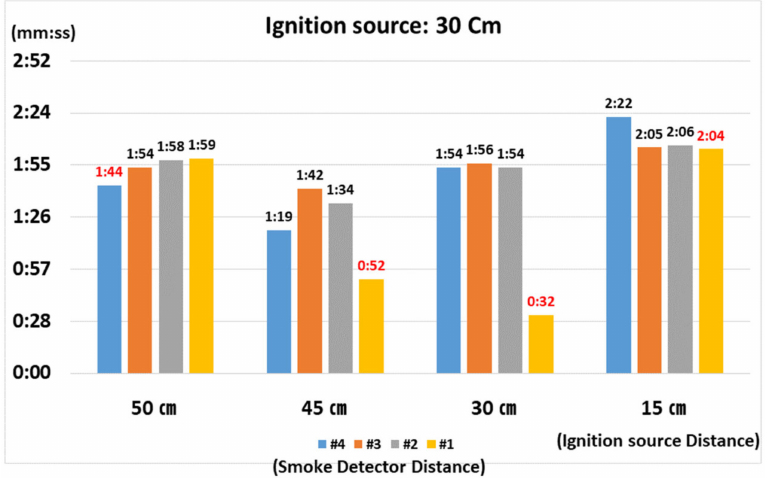
Figure 14. Elapsed time until smoke detection at height of 30 cm from ignition source. CO Concentration